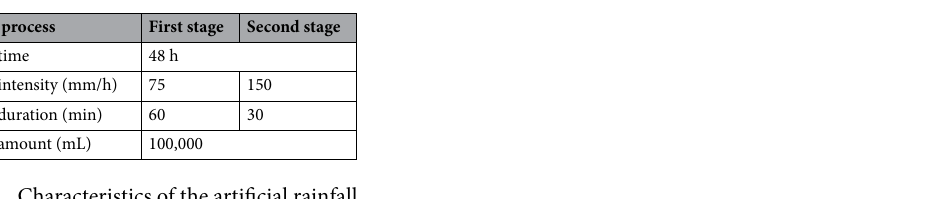
Table 3. Characteristics of the artificial